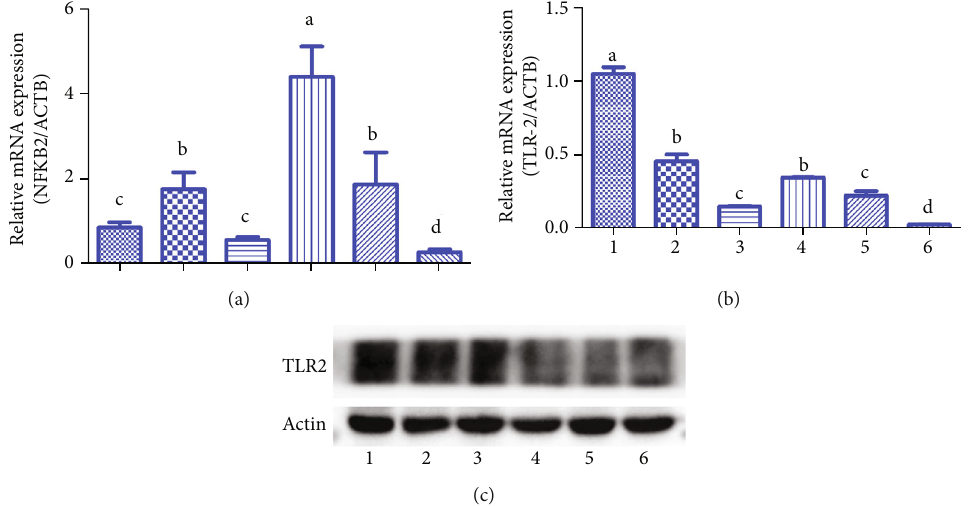
Figure 5: The mRNA and protein expressions of NF- κ B2 and TLR2 in the spleen. Total RNA was isolated from the spleen samples collected at 30 days postimmunization. The spleen tissues were homogenized using RIPA bu ff er.